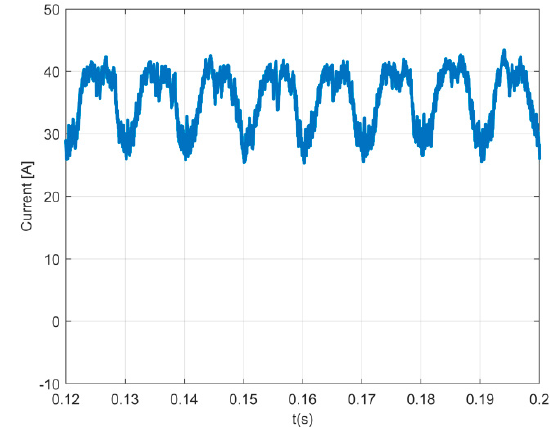
Figure 7. The motor winding current (i A ).